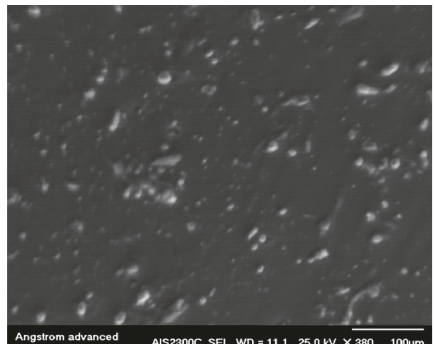
Figure 3: 5% by weight polyester powder